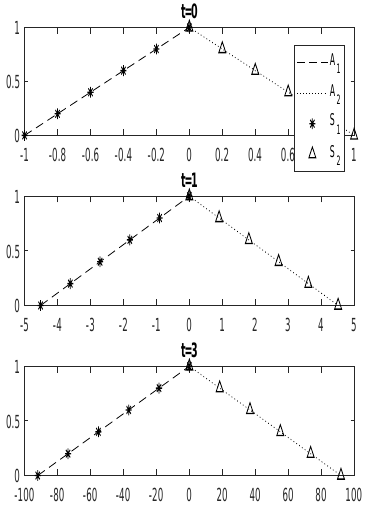
Figure 5. Line graph for differential Equation (4) with FICs.